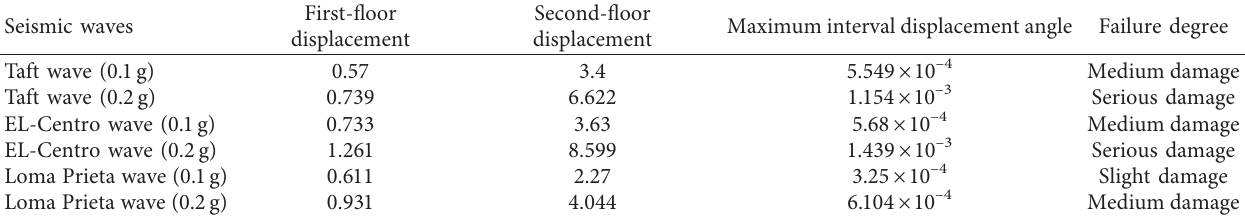
Table 5: Structure maximum displacement (mm), maximum interval displacement angle, and failure degree.